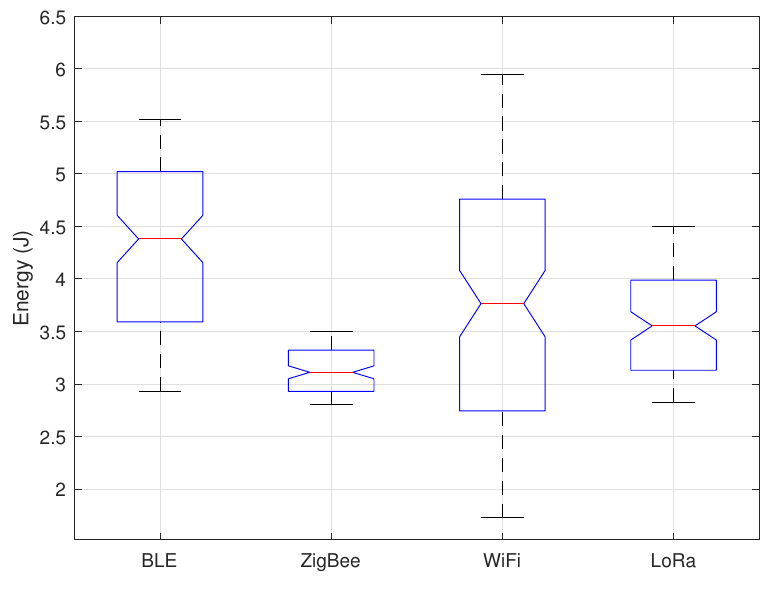
Figure 11. Energy in Joules under collaboration scheme for each